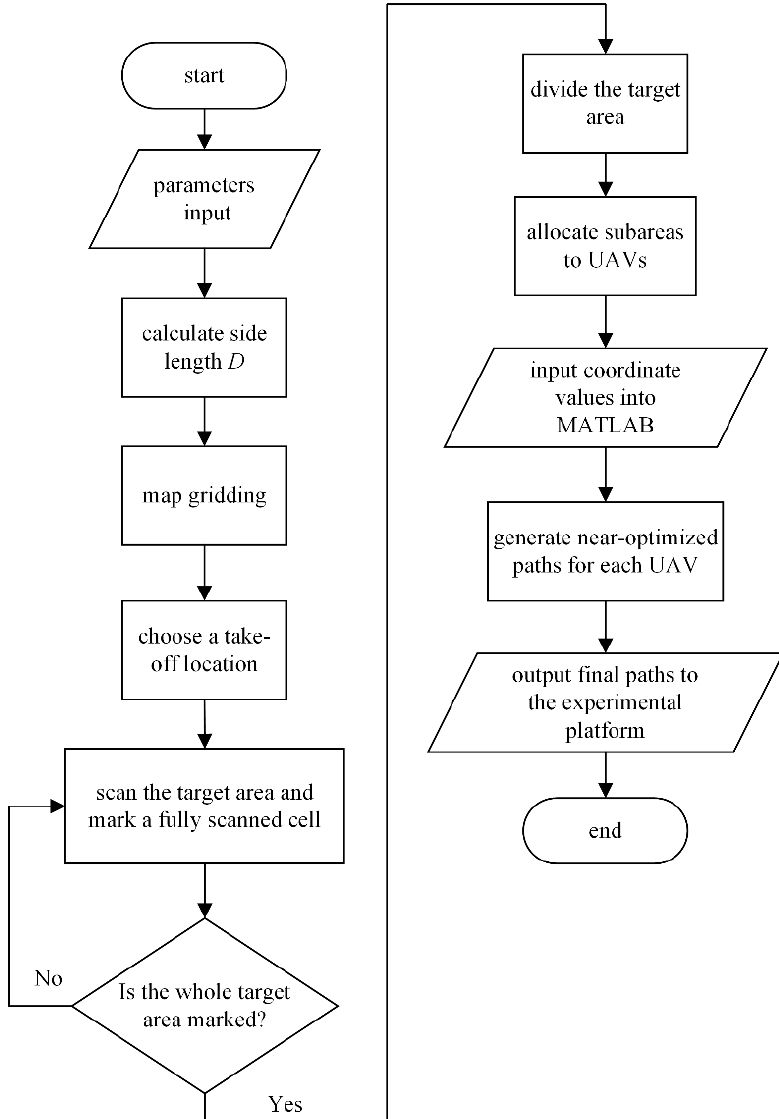
Figure 5. Flowchart of the proposed system.